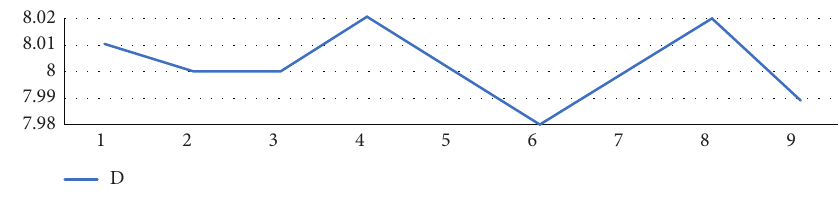
Figure 17: Deviation of the hole parameter extraction. Table 1: Positioning accuracy.